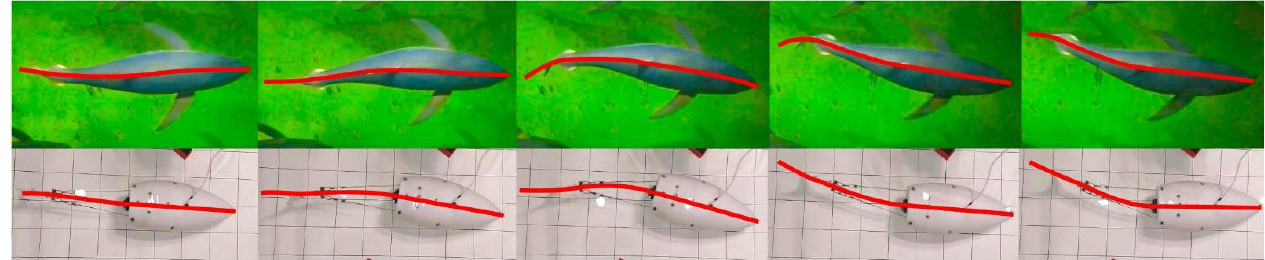
Figure 5. Snapshots from a video of a tuna and the robotic fish swimming. The middle line is marked in red.